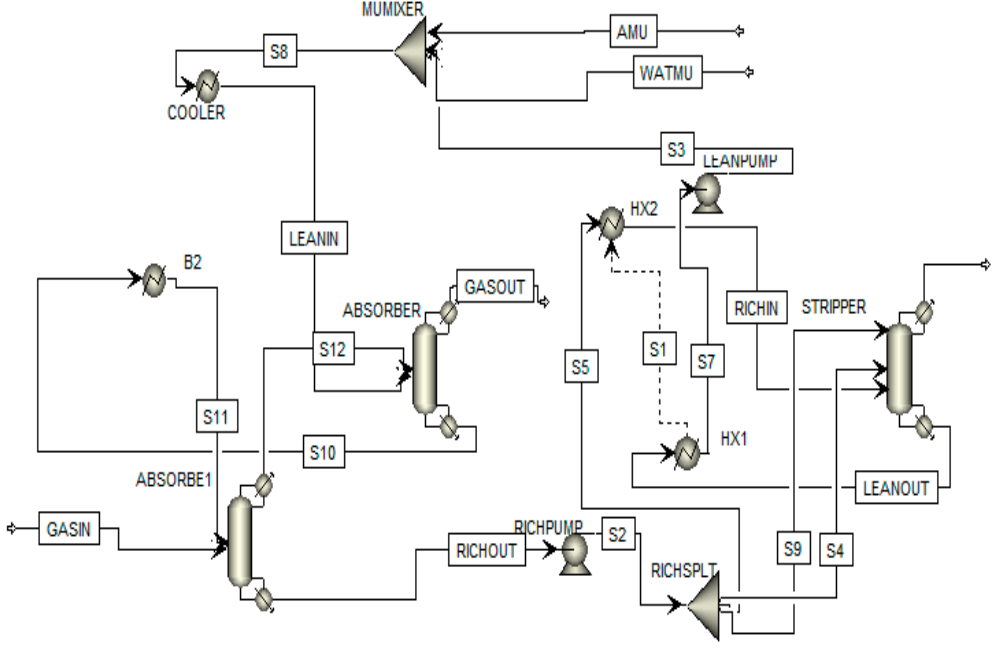
Figure 5. Rich split with intercooling configuration.